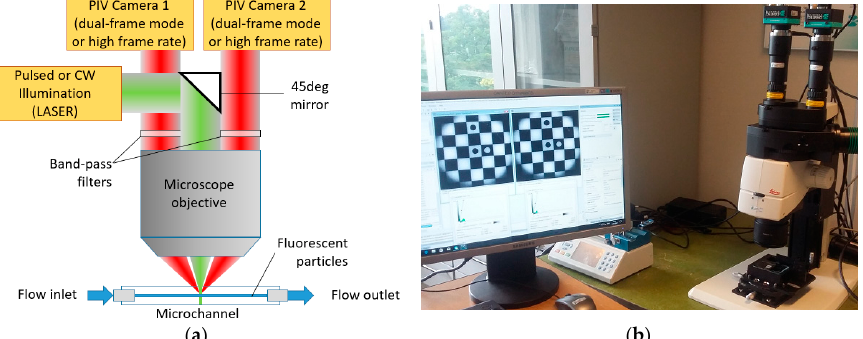
Figure 3. ( a ) Two-dimensional three-component Micro-Particle Image Velocimetry (2D3CµPIV) measurement in back-scatter illumination mode. ( b ) A 2D3CµPIV system featuring a fluorescence stereo microscope, two PIV cameras, a calibration kit, and a syringe pump.